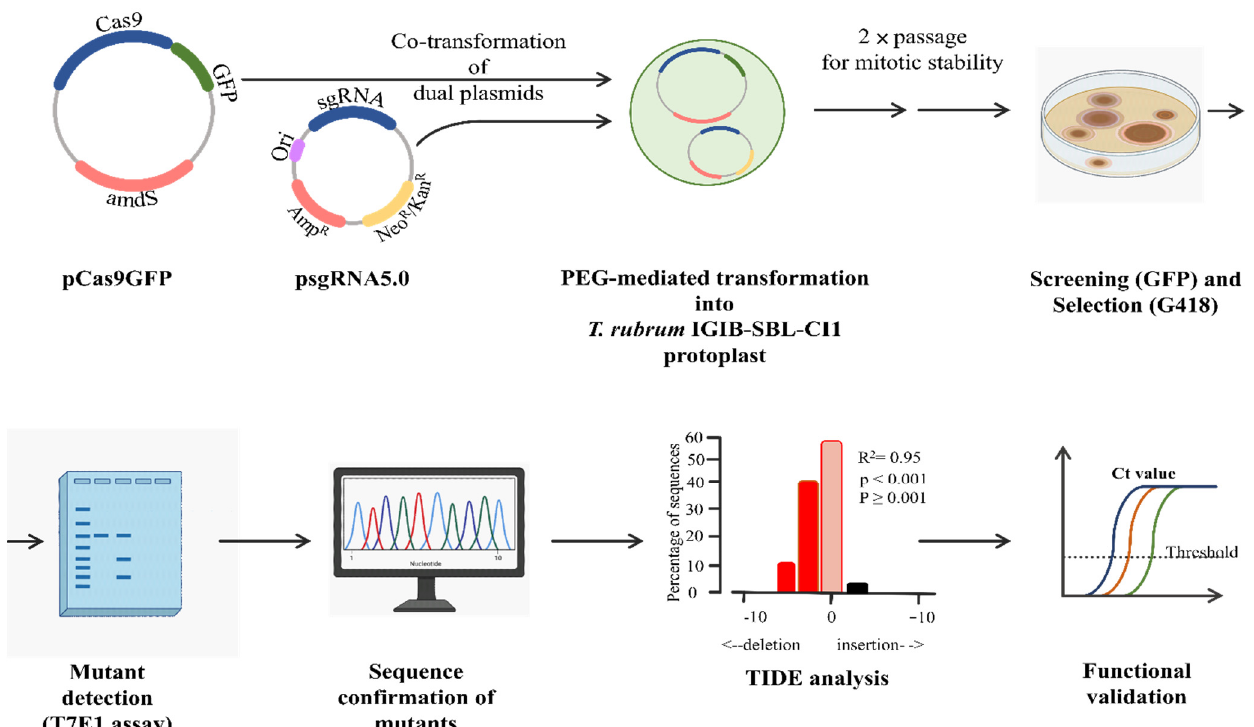
Figure 1. Schematic illustration of dual-plasmid-based CRISPR/Cas9 strategy for gene knockout of pacC. sgRNAs were designed and cloned in psgRNA5.0. Co-transformation by PEG-mediated method, with pCas9gfp, yields primary transformants. GFP-expressing mitotically stable transformants were screened on selection media. Cas9-GFP generates a double stranded break guided by pacC-specific sgRNAs. An error prone NHEJ repair results in mutants. Mutant detection by T7E1 was followed by further confirmation by sequencing and validation of loss of function of pacC in vivo.